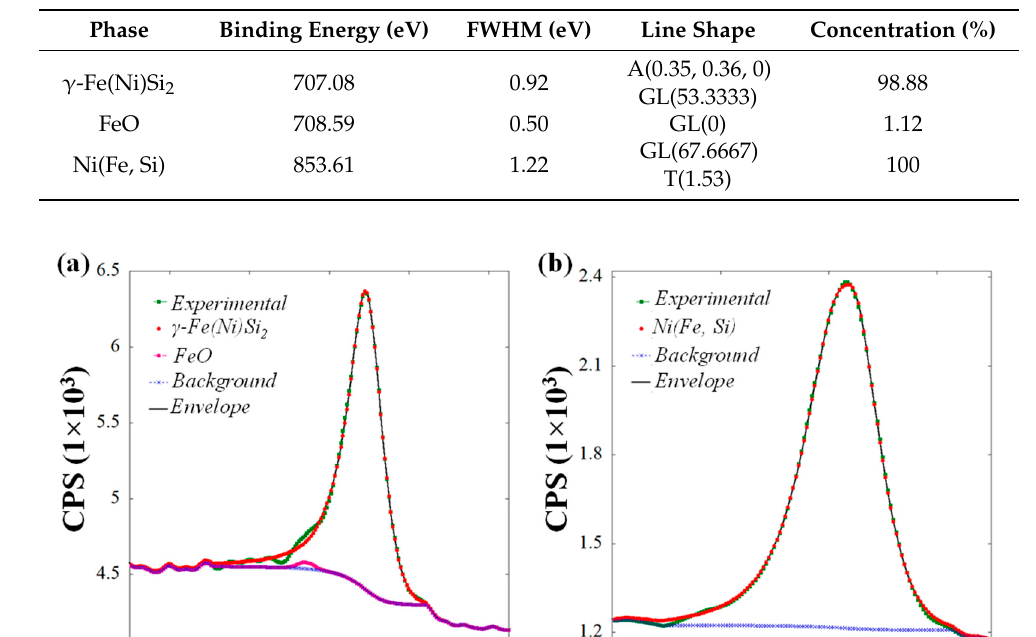
Table 1. Fitting parameters to high-resolution core level XPS spectra of Fe 2 p 3/2 and Ni 2 p 3/2 peaks (from Figure 2).